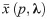
Graphical Representation of the Response Surface Identification.The relationship x(p) between a controller parameter p (in this work, step-frequency) and the physiological objective x (in this work, metabolic energetic cost) was replicated by a response surface x‾(p,λ) defined by a set of shape parameters λ. The shape parameters were identified to minimize the error between predicted respiratory response y‾ (based on a model of the measurement dynamics [20]) and actual measures y^. This dynamic estimation process enabled us to use non-steady-state breath-by-breath measures to approximate the relationship between the control parameter p and energetic cost x. Optimization was performed with respect to the response surface, x‾(p,λ), that approximates the energy-parameter relationship.